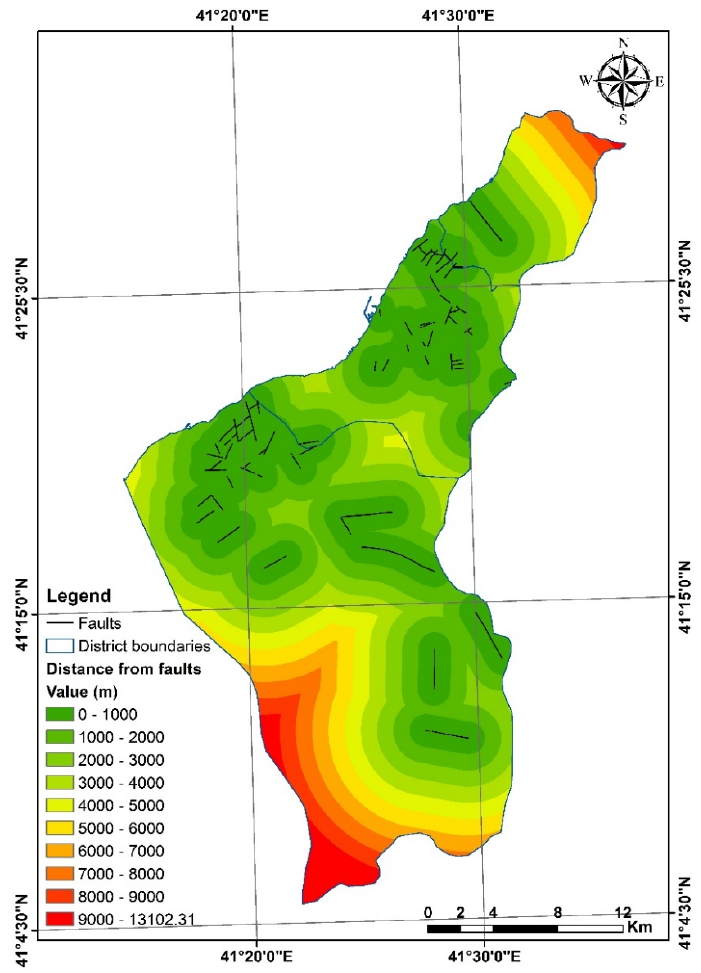
Figure 5. Map of the distance from the fault lines.